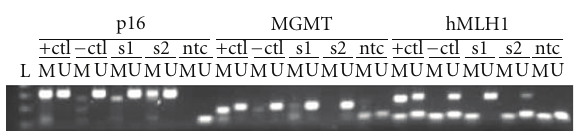
Figure 1: Agarose gel electrophoresis of PCR products of gene pro- moter methylation of (a) MGMT, (b) hMLH1, and (c) p16 INK4A . L: DNA ladder 50bp, +ctl: DNA treated with SssI, − ctl: unmethylated DNA control, s1,s2: clinical samples negative for methylation for MGMT and hMLH1. s2 is positive for p16